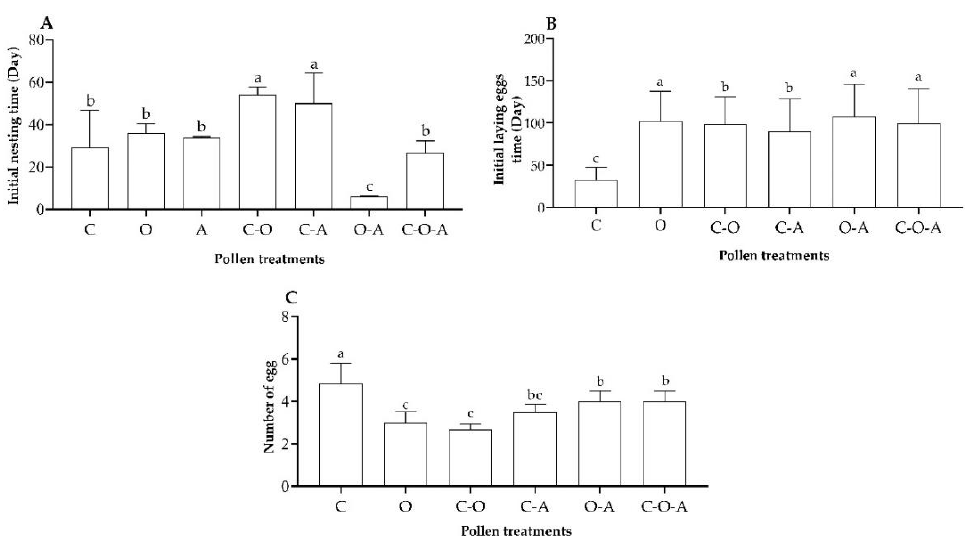
Figure 3. Parameters for the initial nesting and egg laying and larval ejection behaviors of each pollen treatment: ( A ) initial nesting time; ( B ) initial egg-laying time; ( C ) number of eggs. C: camellia pollen mix; O: oilseed rape pollen mix; A: apricot pollen mix; C–O: camellia–oilseed rape pollen mix; C–A: camellia–apricot pollen mix; O–A: oilseed rape–apricot pollen mix; C–O–A: camellia–oilseed rape–apricot pollen mix. The data having same letter represents with no differences among treatments ( p > 0.05), and the data having different letter represents with have significant differences among treatments ( p <